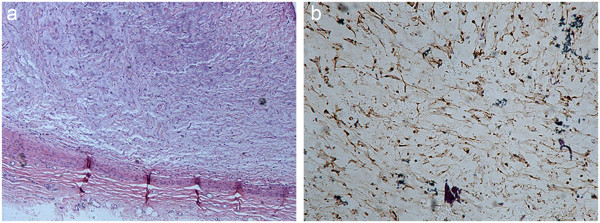
Pathology result of subcutaneous nodules. (a) Hematoxylin and eosin (HE) staining of subcutaneous nodules revealed the diagnosis of neurofibroma accompanied by mucinous degeneration (magnification × 40). (b) Immunohistochemistry staining for S-100 protein was positive (magnification × 40).